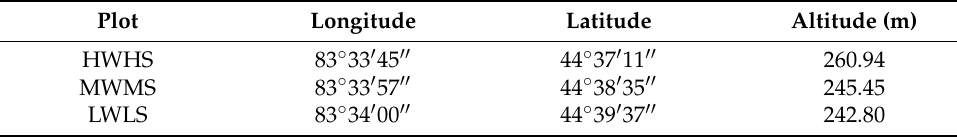
Table 1. Detailed information about the location of the three plots.